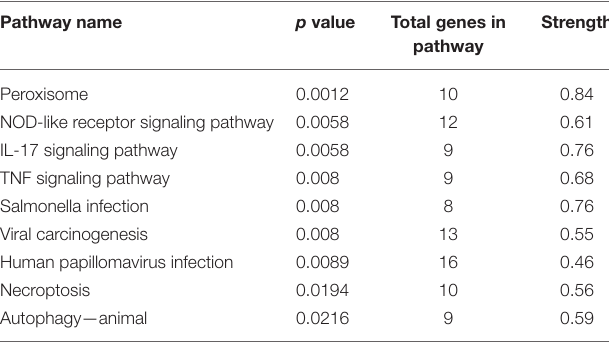
TABLE 4 | The significant KEGG metabolic pathways associated with the common